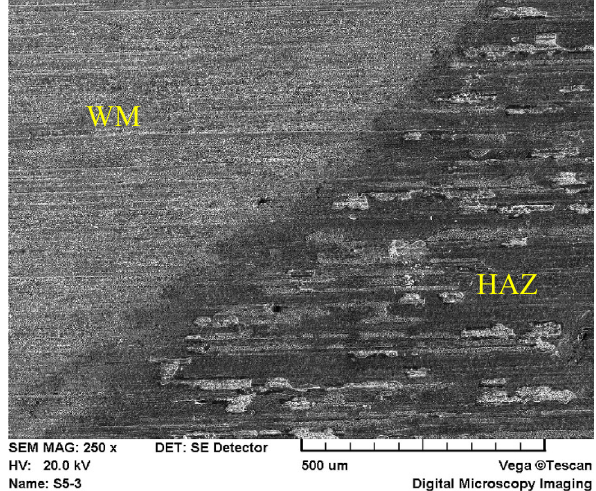
Fig. 5. Spalling of surface layer on welded specimen of Alloy 800 H after exposure of 1500 hours at 760 ° C in impure helium.